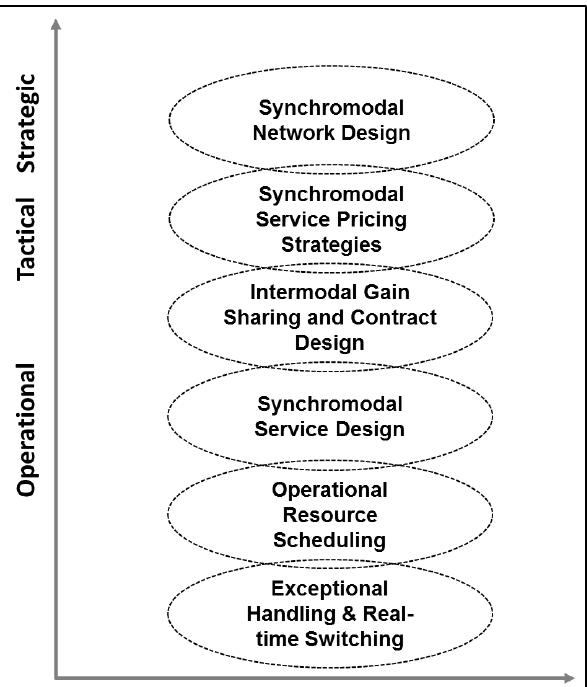
Figure 4. Hierarchy of decision problems in a Synchromodal Freight Transport